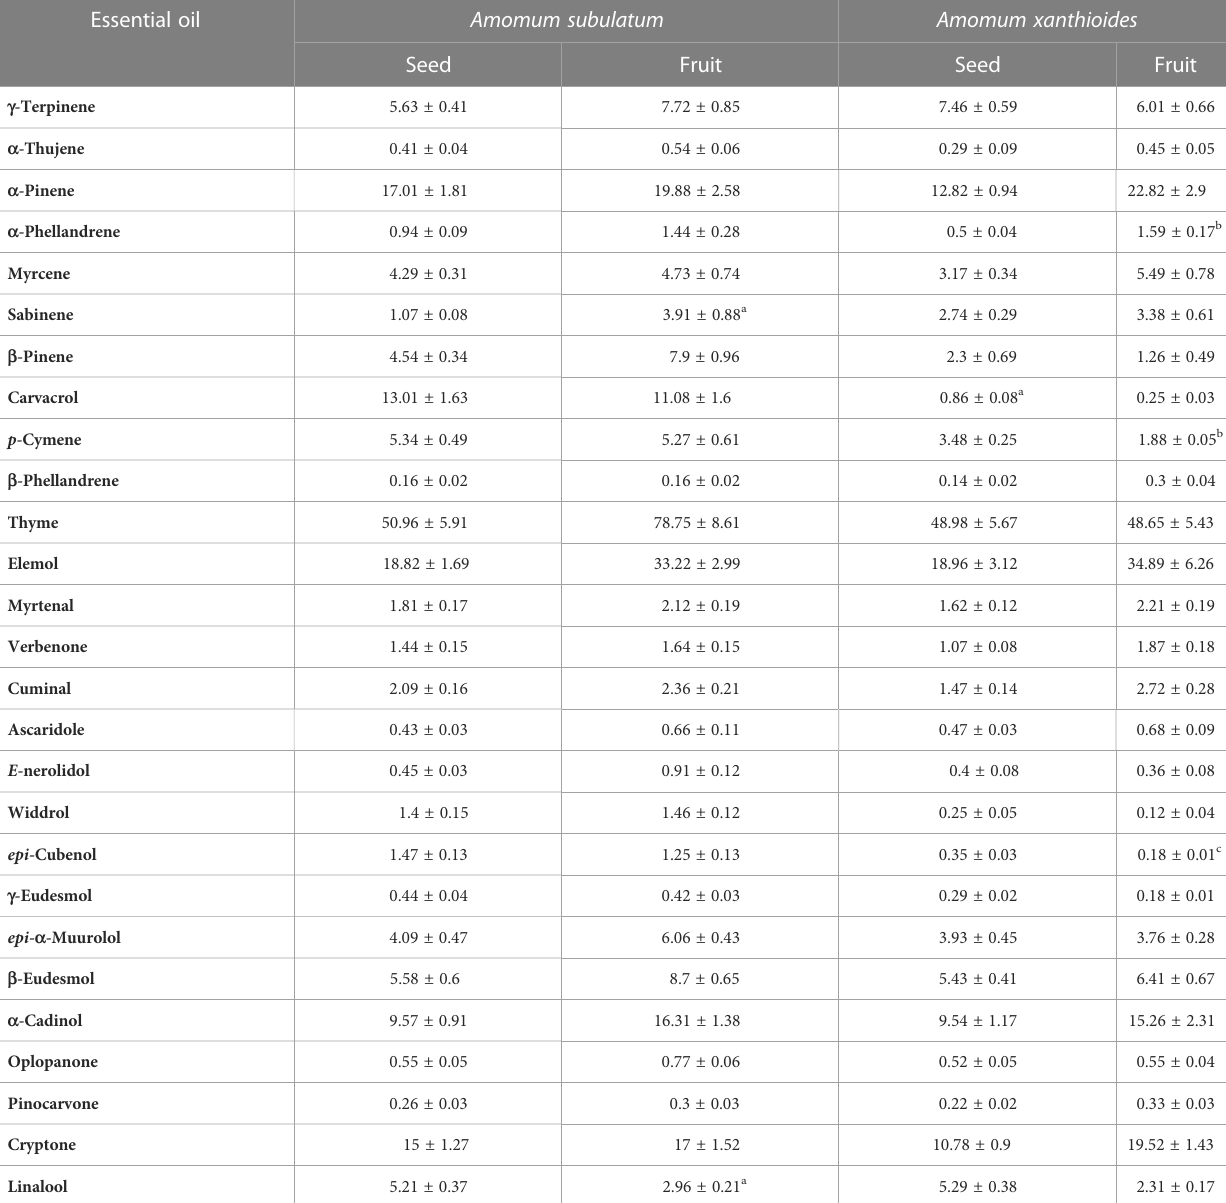
TABLE 1 Essential oil percentages (v/g dry weight) in the seed and fruit of Amomum subulatum and Amomum xanthioides . Essential oil Amomum subulatum Amomum xanthioides Seed Fruit Seed